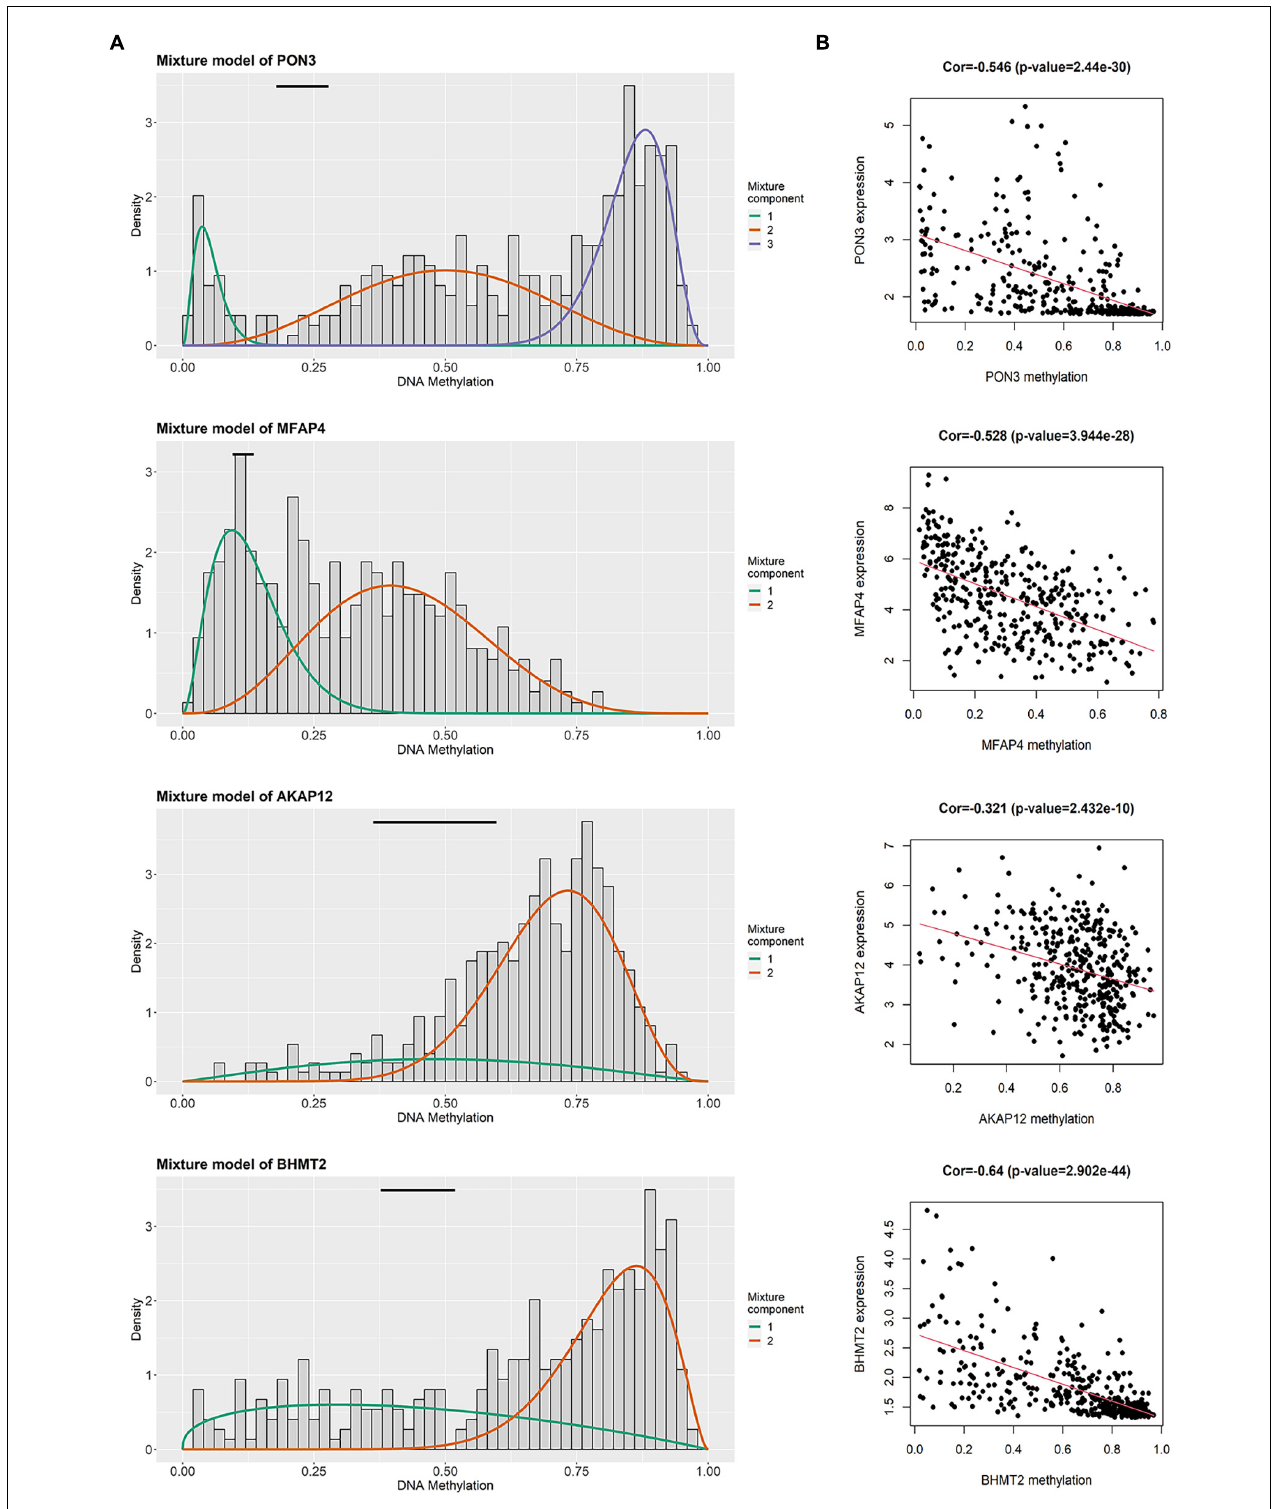
FIGURE 2 | Summary of four methylated related genes in the signature. (A) The distribution map of methylated status of four genes. The histogram demonstrates the distribution of methylation in tumor samples. Horizontal black bars show the distribution of methylation in normal samples. (B) The correlation between DNA methylation level and mRNA expression level in four